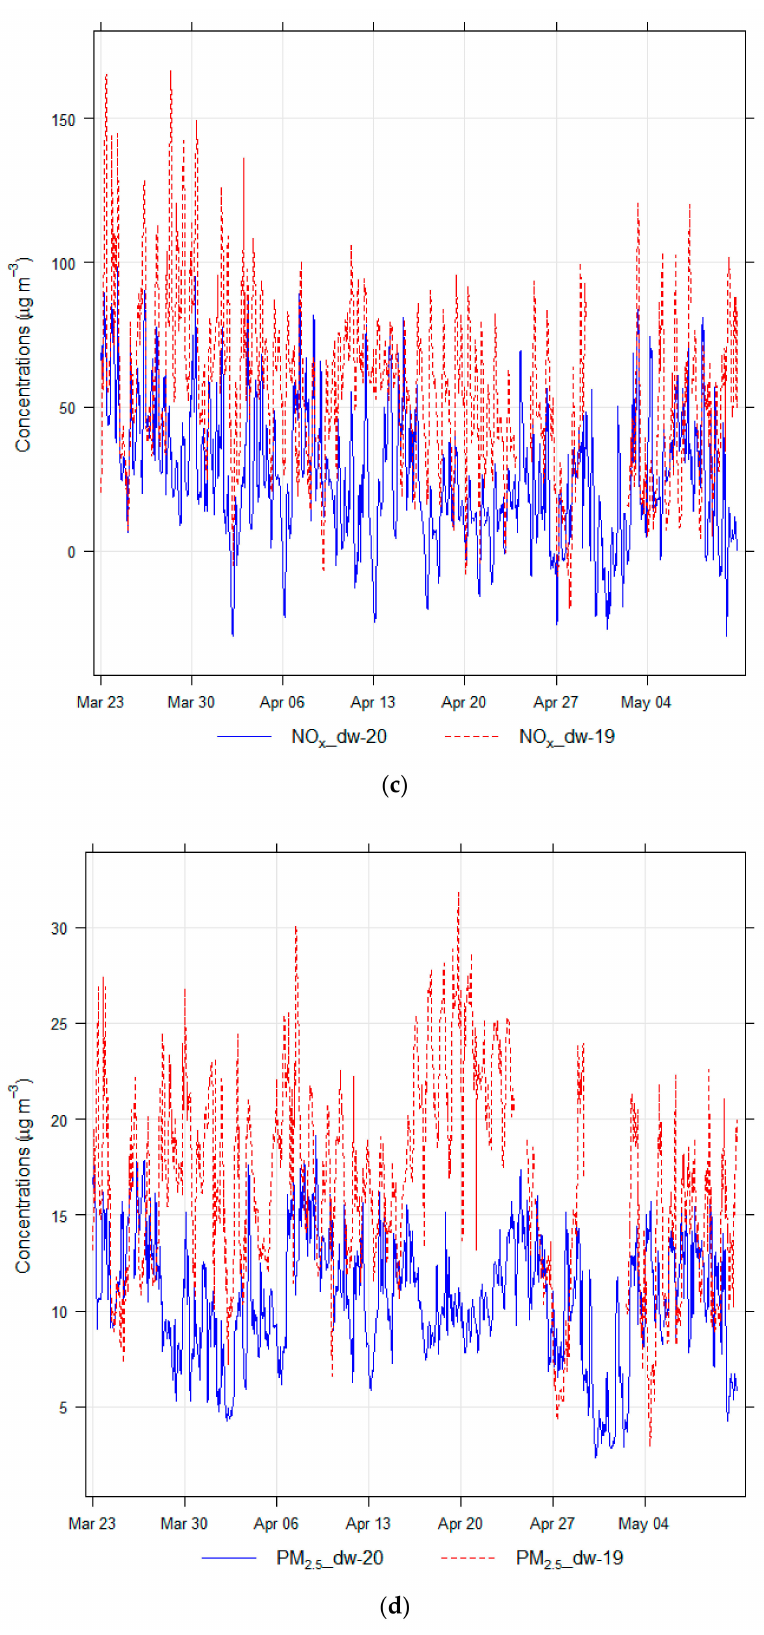
Figure 8. Comparison of deweathered mean hourly air quality data between lockdown period 2020 with the equivalent period in 2019 at Manchester Piccadilly AQMS. ( a ) NO; ( b ) NO 2 ; ( c ) NO X ; ( d ) PM 2.5